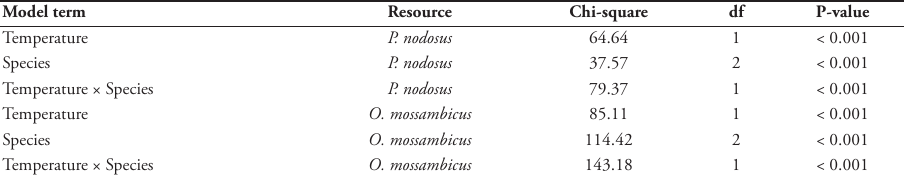
Table 2. Model terms for all factors from GLM with a quasi-Poisson error distribution used to determine differences in macrophytes consumption and fish scavenging with regards to factors “temperature” and “species”, using a Type 3 ANOVA and χ 2 to report the